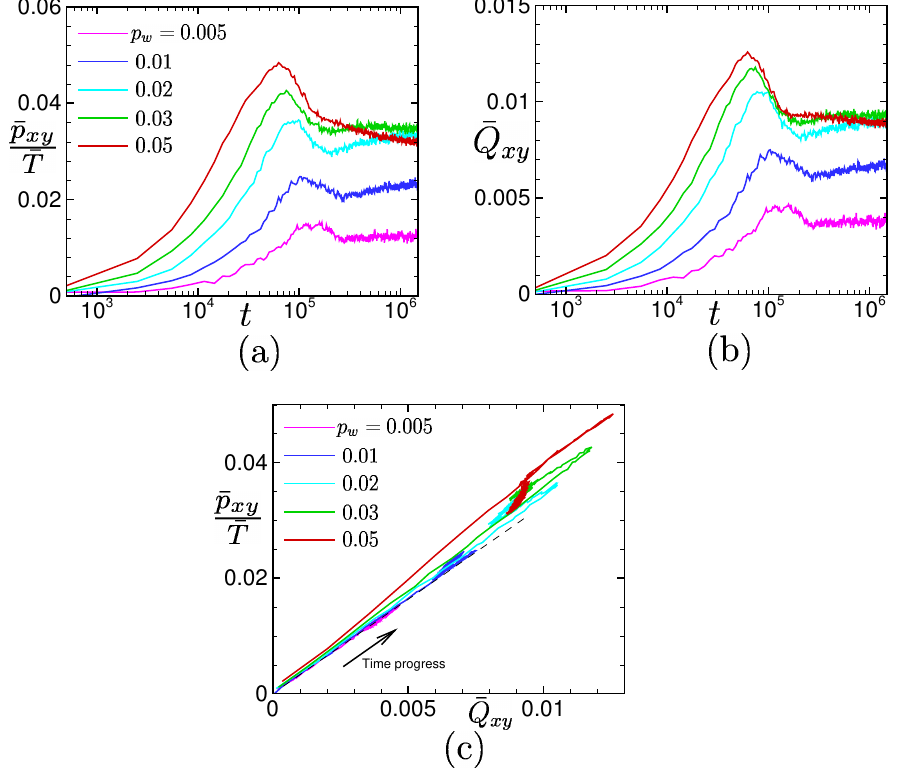
Figure 12. ( a ) Time evolutions of the spatial averages of the local shear stresses divided by the temperatures ¯ p xy / ¯ T , ( b ) time evolutions of the spatial averages of the local bond orientations ¯ Q xy , and ( c ) the time evolution of the relation ¯ p / ¯ T vs. ¯ Q xy for different drive forces p w = 0.005, 0.01, 0.02, 0.03, and